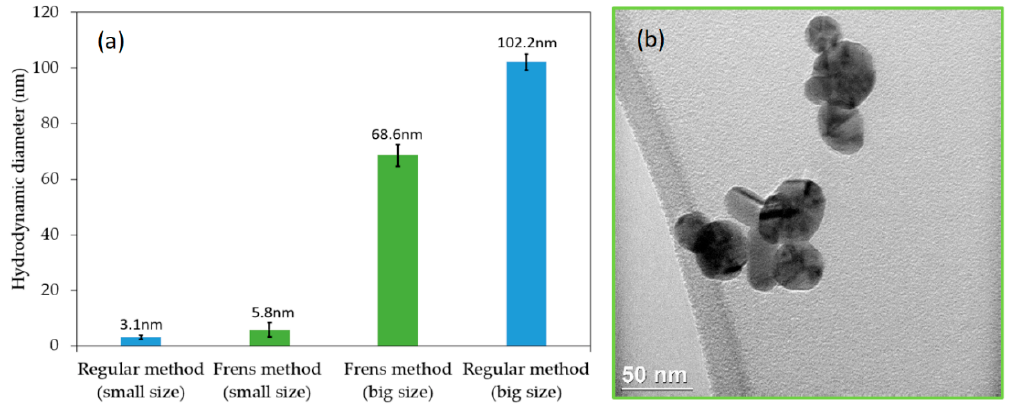
Figure 3. Determination of the nanoparticle size obtained by using the methods described in this protocol: ( a ) Using dynamic light scattering (DLS); ( b ) by transmission electron microscopy .